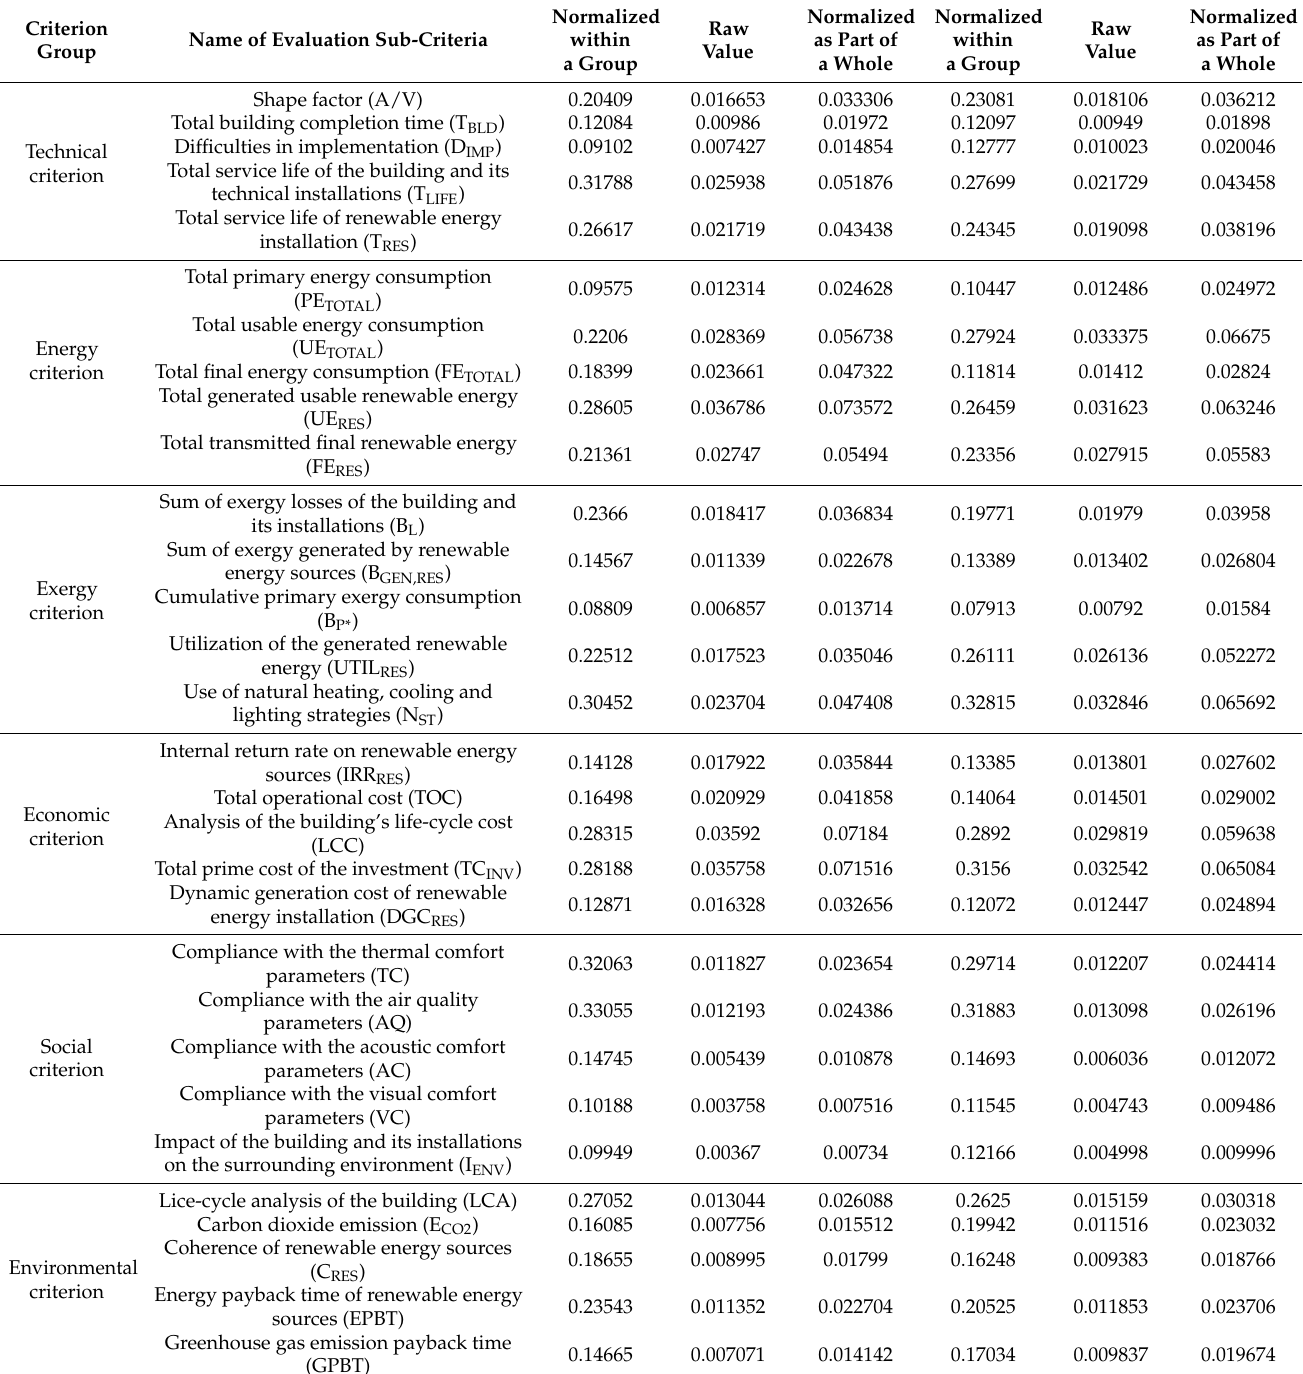
Table 4. Weight vectors for all evaluation sub-criteria—“Current/Future user” and “Designer/Architect”.